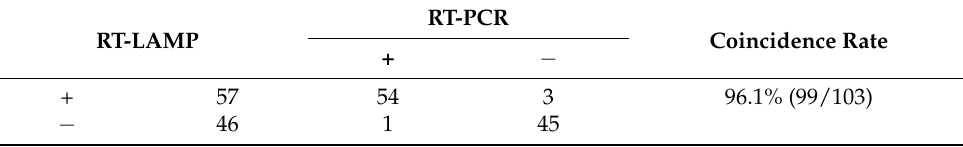
Table 2. Detection results of 103 clinical specimens by RT-LAMP and